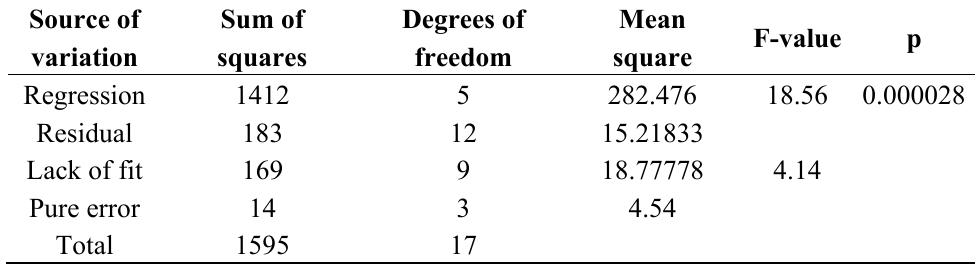
Table 4. ANOVA for the central composite design after 96 h of reaction.